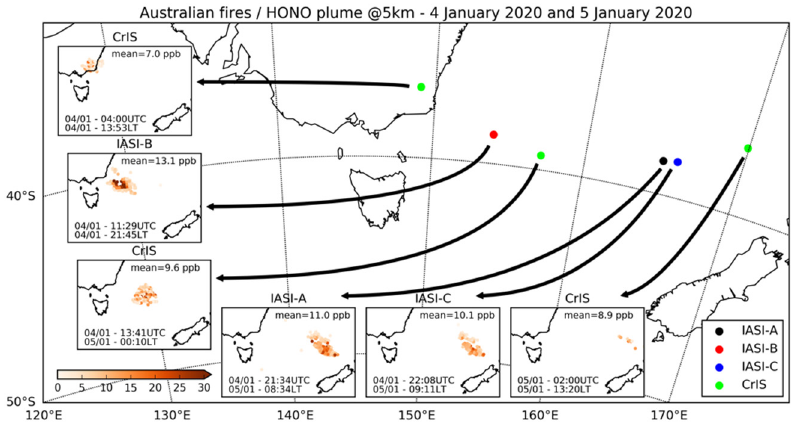
Figure 3. HONO plume tracked by CrIS and IASI instruments. The location of the center of the plume (mean latitude and longitude) is indicated in the main panel. HONO vmrs retrieved for each detection are plotted in the different subpanels. The time of the detection is indicated in UTC and Local Time (LT).